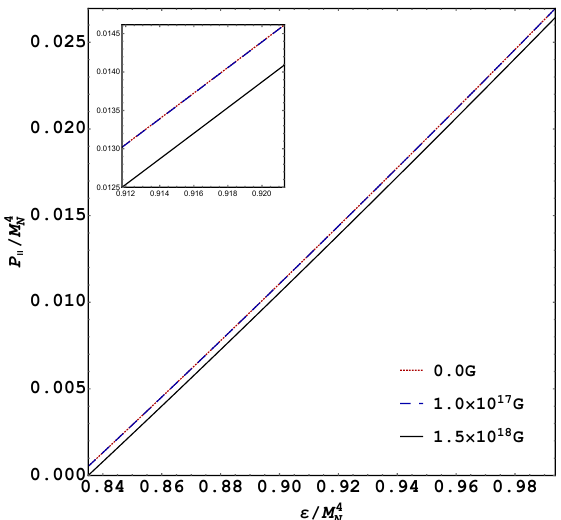
Figure 4. (Color online) Equations of state for the parallel pressure for magnetic field strengths of 0.0 G (dotted), 1.0 × 10 17 G (dashed), and 1.5 × 10 18 G (solid). The curves for the two lower fields